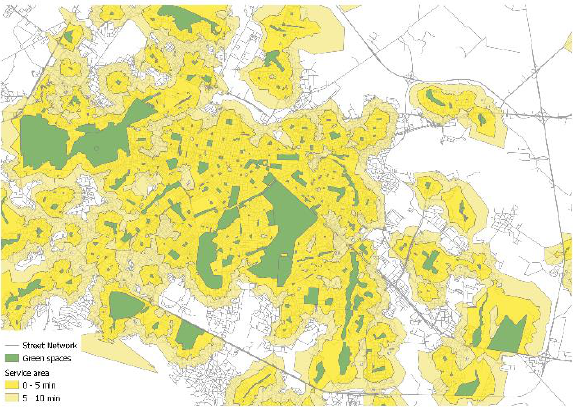
Figure 13. Network Analysis service area of parks in South areas.